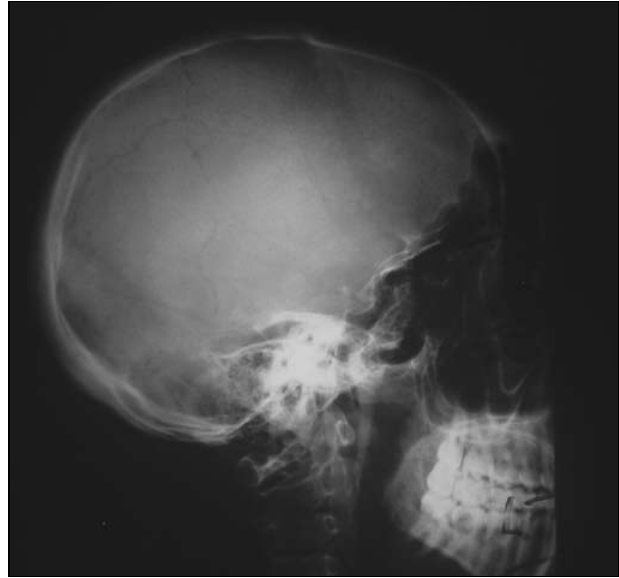
Fig. 1a. Lateral skull radiograph. Teflon felt is not visible